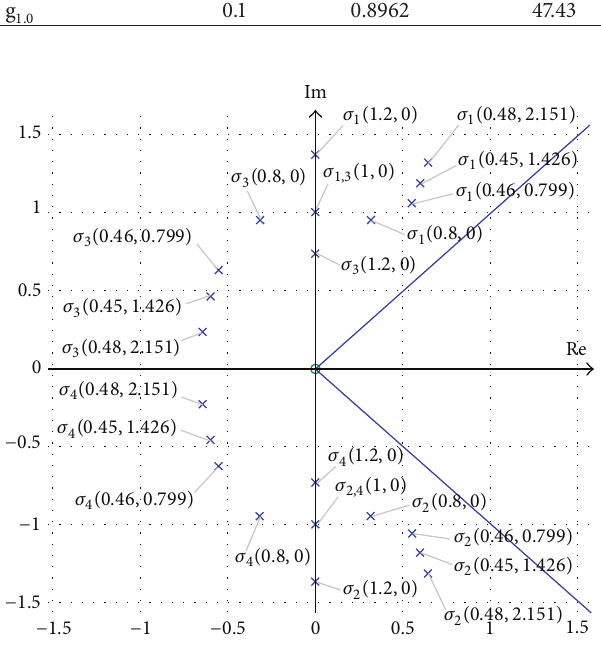
Figure 10: Pole locations for the six cases of Table 4. right half-plane; therefore, the system behaviour is always oscillatory.